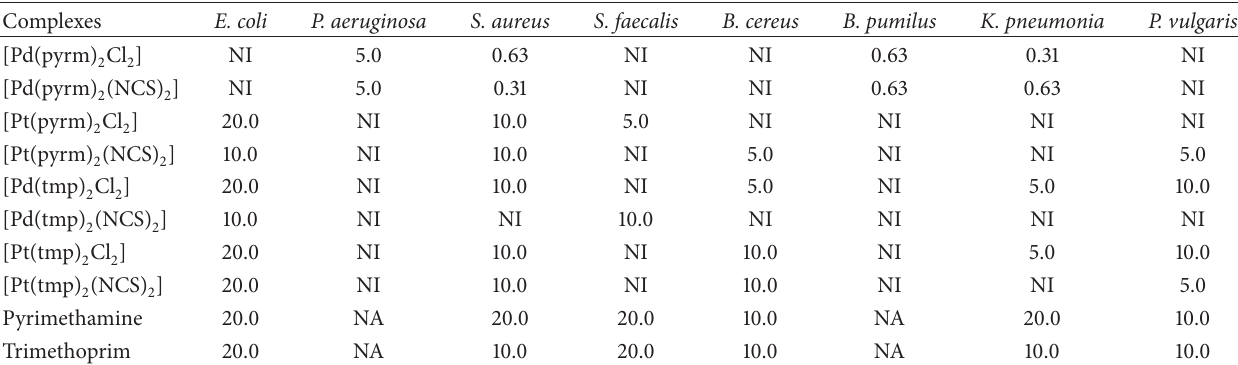
Table 3: MIC values (mg/mL) of the metal complexes on selected bacteria. Complexes E.